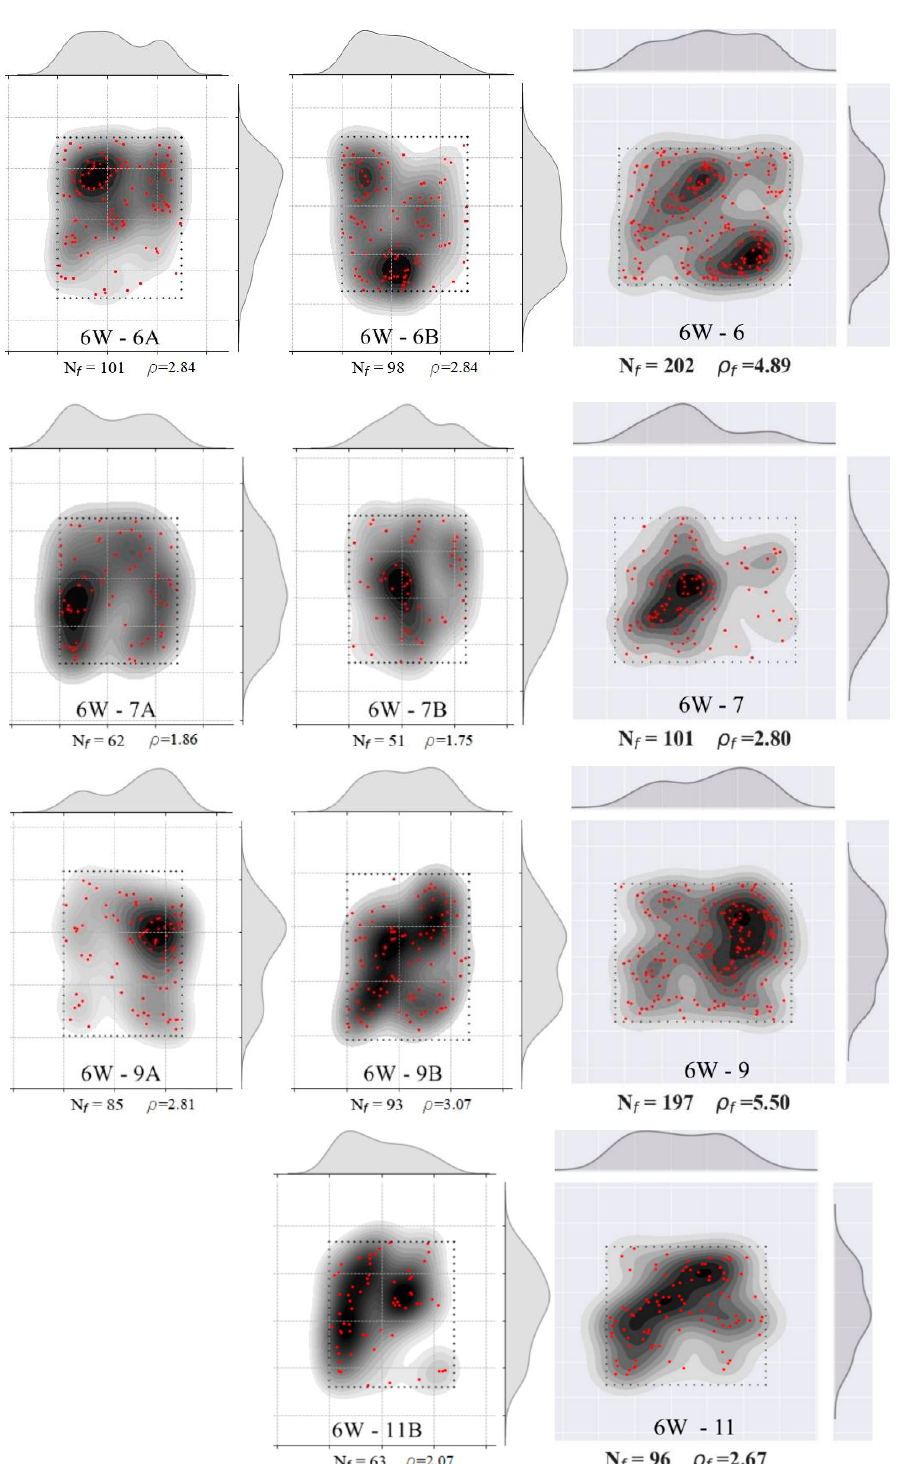
Figure 11. Fiber density and distribution of 6W specimens. Left column corresponds to prism A (shear), middle column corresponds to prism B (shear) and right column corresponds to the flexural case.